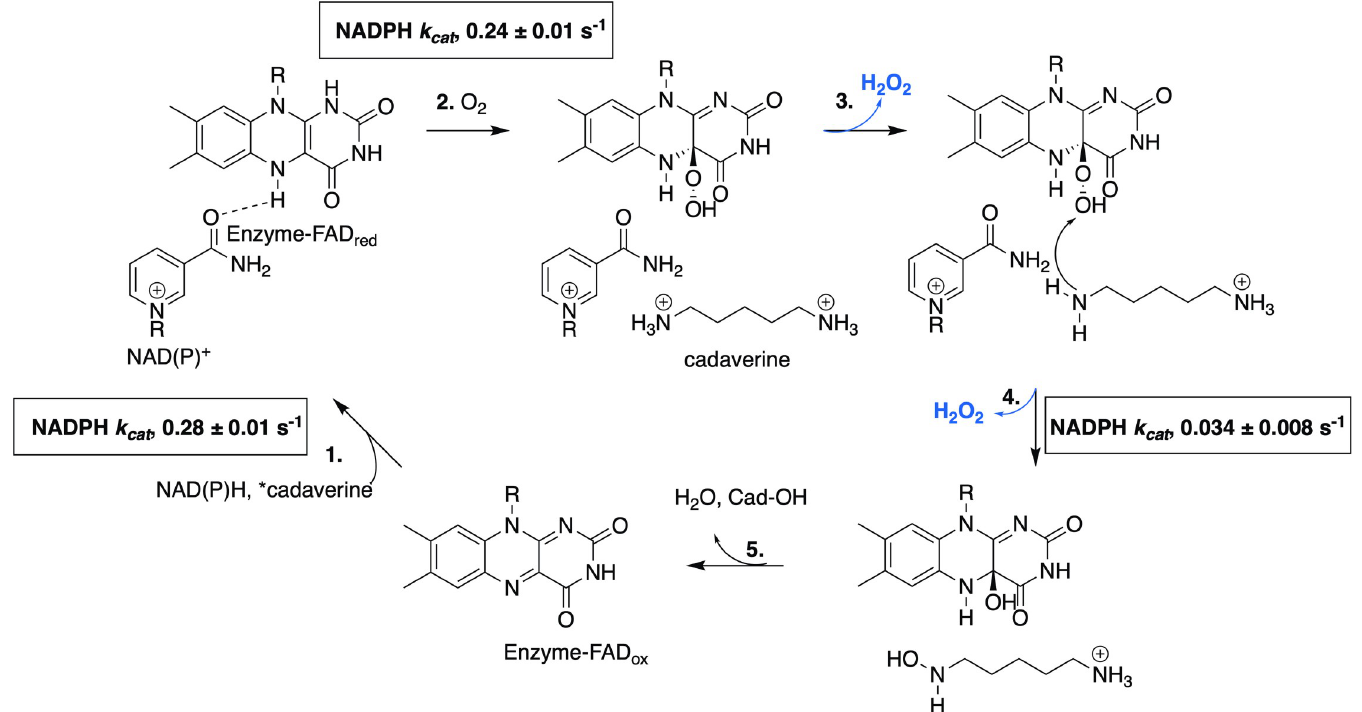
Fig 11. General mechanism for Class B flavin-dependent monooxygenases. The NADPH oxidation, oxygen consumption, and N -hydroxylation steps are represented by steps 1, 2, and 4, respectively. The loss of peroxide is indicated in blue and the apparent k are shown. � , the substrate is either added before or after the reduction of molecular